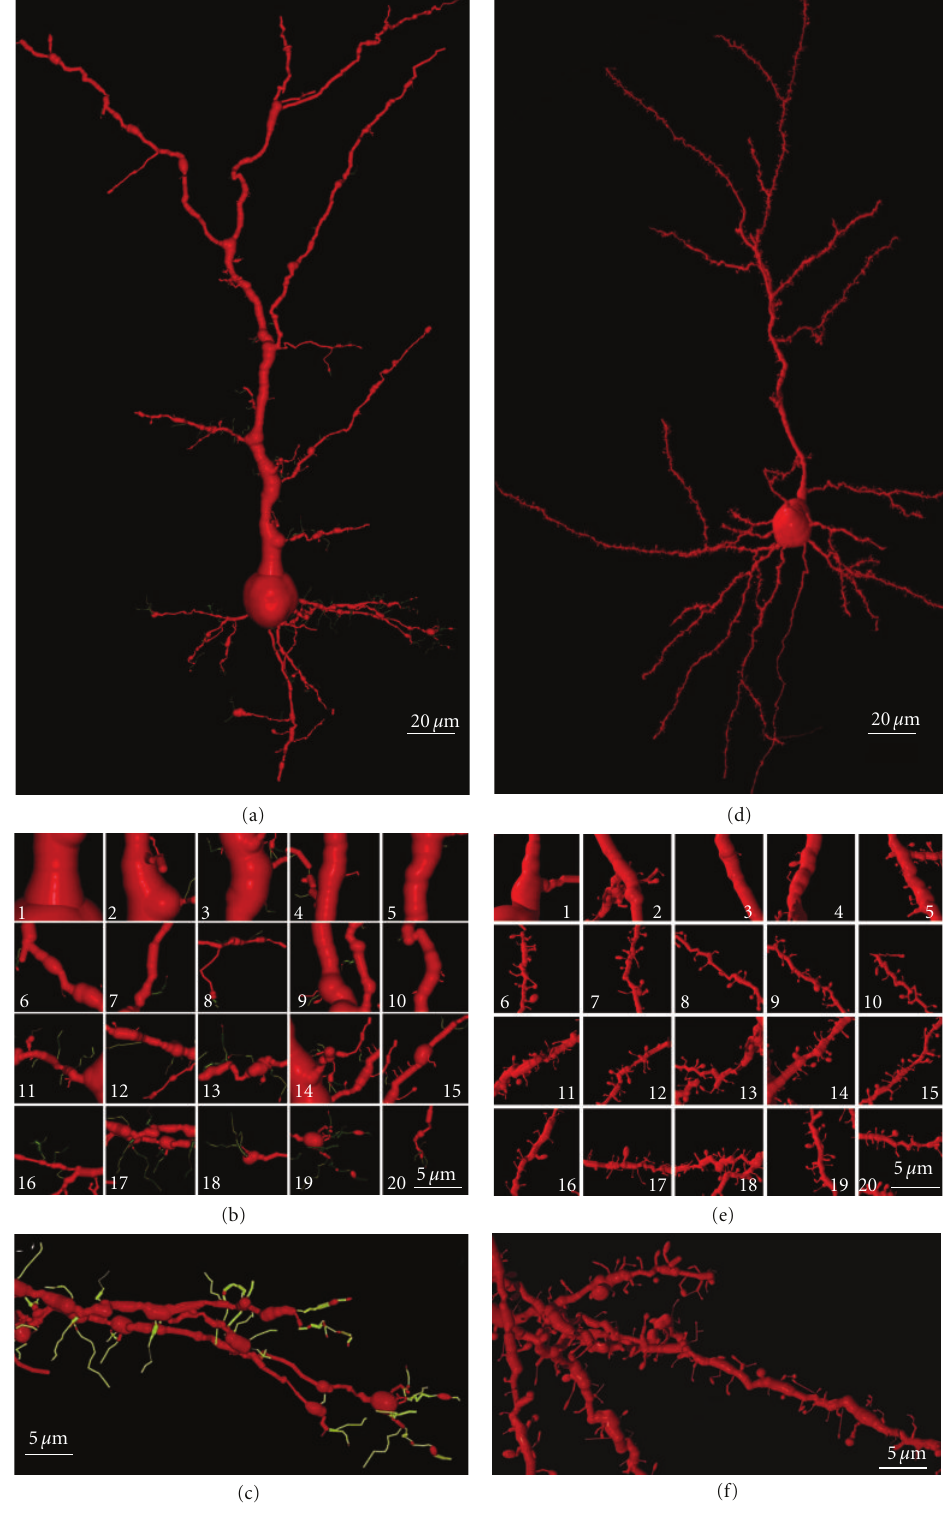
Figure 16: 1112(a) Illustrates a three-dimensional reconstruction, layer III pyramidal cell, “newborn rabbit” according to the label of the Cajal histological preparation, Golgi-method. (b) Magnified parts of (a); 1–5: successive parts of the apical trunk from the soma; 6–10: parts of the oblique dendrites of the apical trunk; 11–20: parts of the basilar dendrites. (c) Magnified basilar dendrite of (a) showing collateral filopodia, protospines, and growth cone filopodia. Filopodia and protospines are color coded in green. (d) Three-dimensional reconstruction, layer III pyramidal cell, “young mouse” according to the label of the Cajal histological preparation, Golgi-method. (e) Magnified parts of (d); 1–5: apical dendrite; 6–10: oblique dendrites; 11–20: basilar dendrites. (f) Magnified basilar dendrite showing di ff erent types of dendritic spines, protospines, and